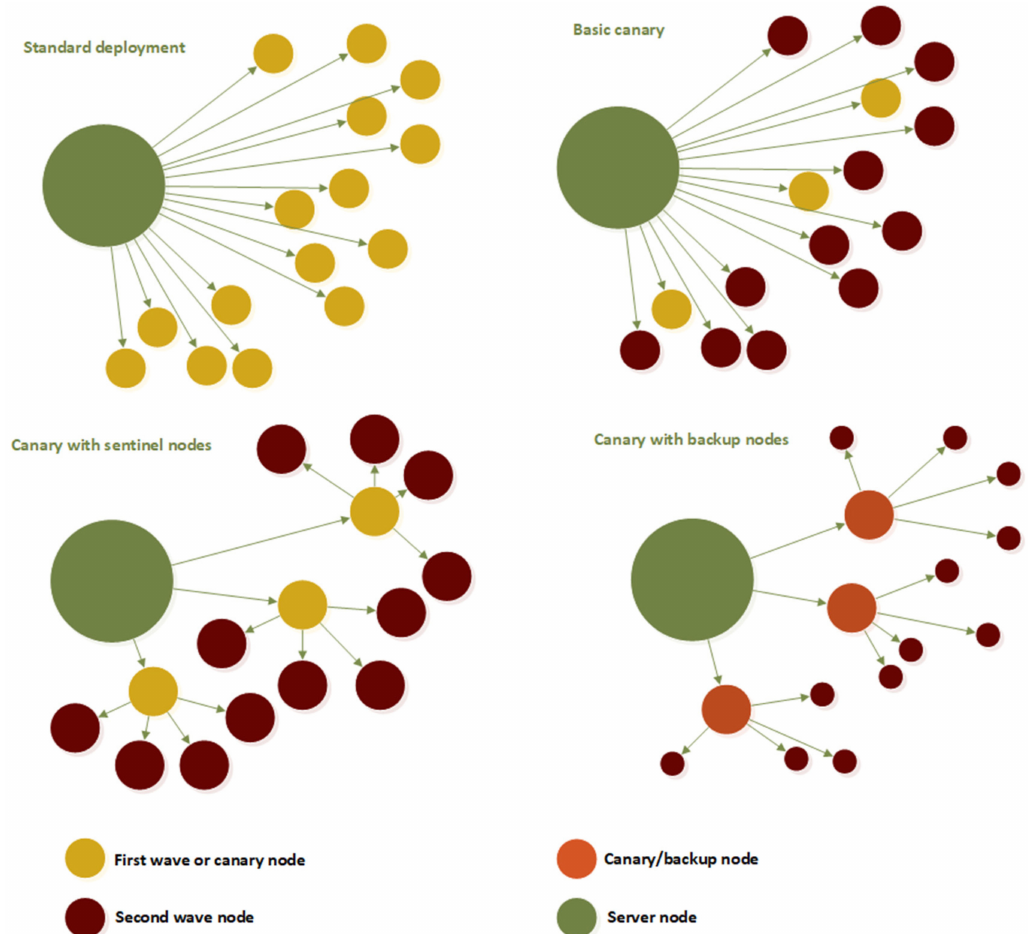
Figure 13. Schematic comparison of analyzed deployment strategies (standard approach, basic canary, canary with sentinel node, and canary with backup